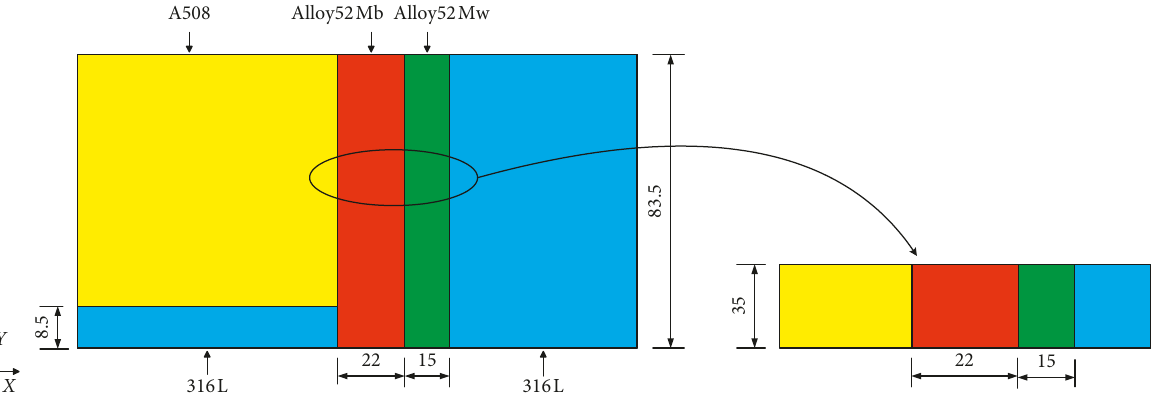
Figure 2: Schematic diagram of the welded joint of the safety